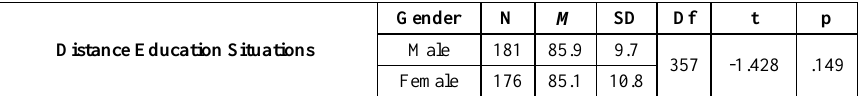
Table 7. Distance education status by gender criteria